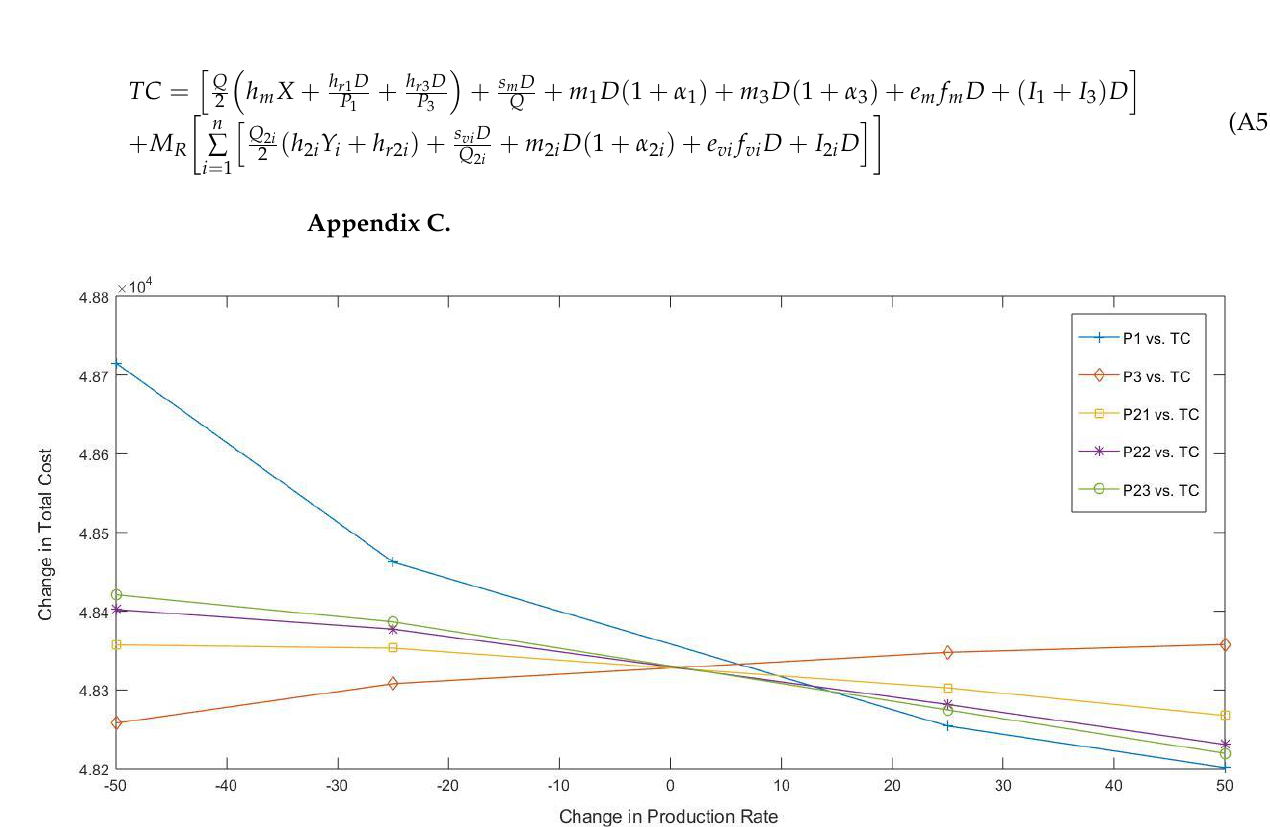
Figure A1. Sensitivity analysis graph for production rate and total cost.